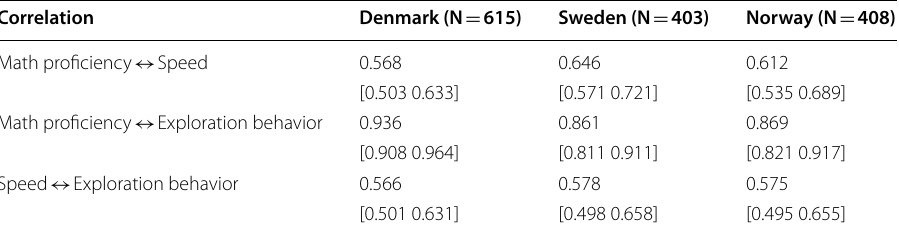
The numbers in the square brackets are the lower bound and higher bound of 95% confidence interval for the correlation coefficients